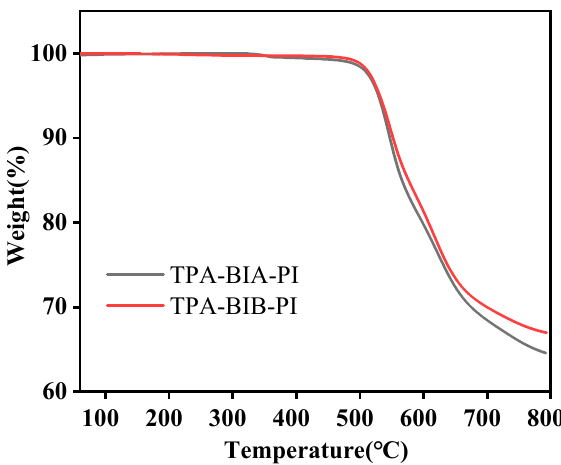
Figure 4. DSC curves of the polyimides.